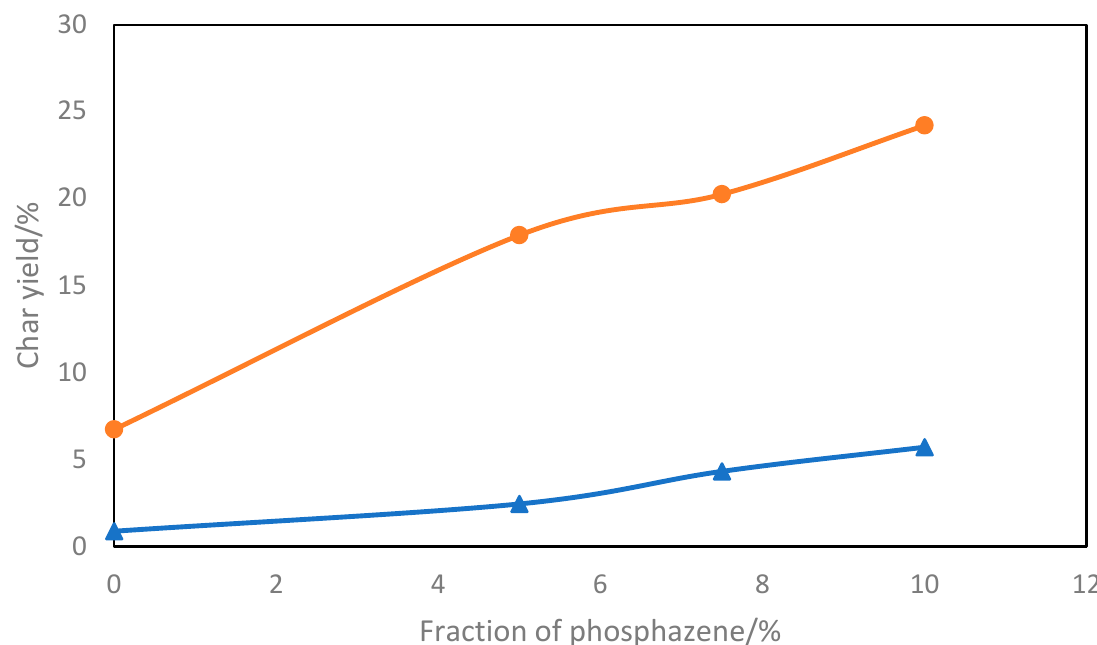
Figure 9. Effect of phosphazene weight fraction on the char yield for epoxy/phosphazene compo- sites, in nitrogen ( ● ) and air ( ▲ ) atmosphere [133].